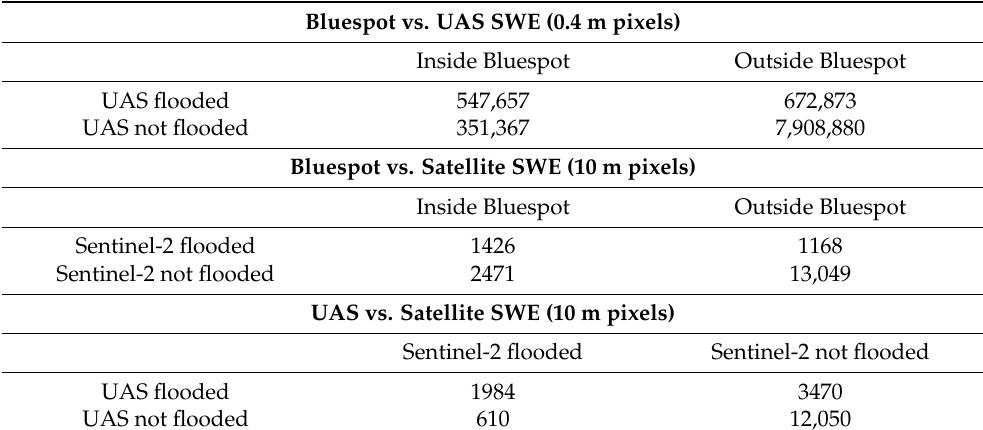
Figure 7. Bluespot areas (blue, threshold 10 mm), UAS SWE (red) and satellite SWE (yellow: Sentinel-2, 19-03-2019) for the Haraldskær area and four zoomed-in sub-areas. Background is spring airborne imagery and dark grey shading indicates areas without UAS flooding status. Panel ( A ) is the overview of the Haraldskær area and ( B – E ) are zoomed-in sub-areas. Table 3. Contingency table for the Haraldskær area. We only report contingency tables for Sentinel-2 SWE because no Sentinel-1 results are available for the date of the UAS thermal